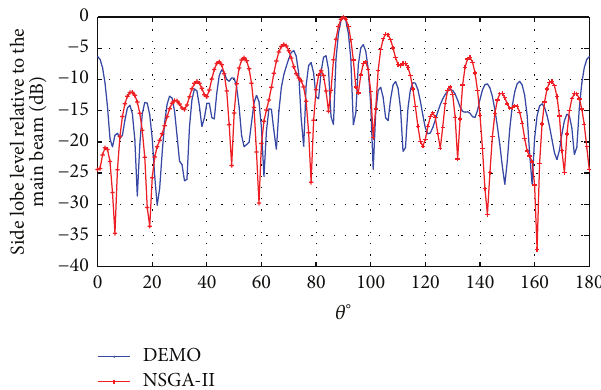
Figure 3: Final solution of the array factor obtained by DEMO/parent in comparison with respect to NSGA-II.